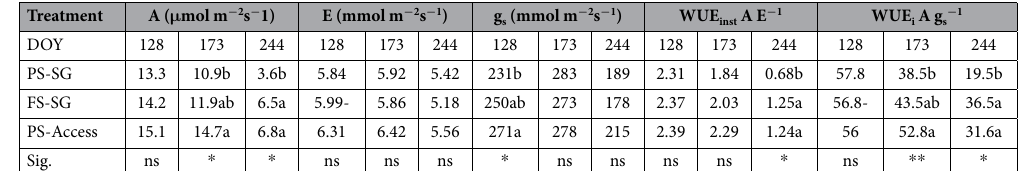
Sig. Table 3. Leaf assimilation (A), transpiration (E) and stomatal conductance (g s ) measured on single leaves of SG (susceptible clone R10) and accession 72-096 (resistant) prior whole canopy system setup (May 18, DOY 128) and right after first and final dismantling (22 June, DOY 173 and 1 September, DOY 244, respectively). Instantaneous water use efficiency (WUE inst ) and intrinsic (WUE i ) were calculated accordingly. PF = partially sprayed. FS = fully sprayed. * and ** denote significant differences between treatments at P < 0.05 and 0.01 according to within column mean separation performed with SNK test and showed by small letters. ns = not significant.